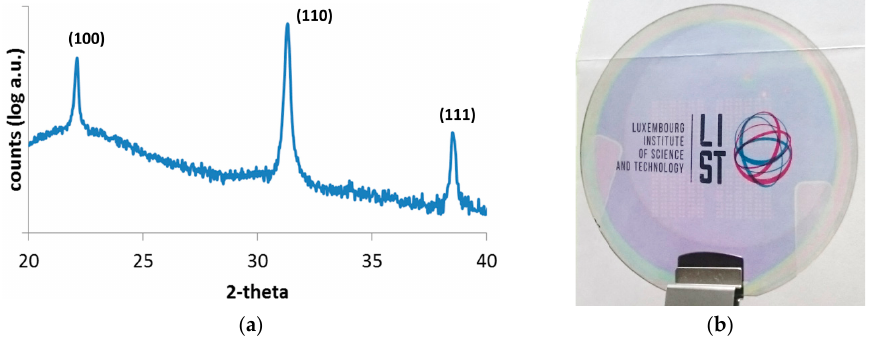
Figure 1. ( a ) The θ -2 θ pattern of 200-nm-thick Pb(Zr 0.52 Ti 0.48 )O 3 (PZT) film deposited by spin coating on TiO 2 /fused silica and crystallized at 700 °C. All peaks correspond to the perovskite structure; ( b ) Optical image of a 2’’-diameter wafer coated with 20 nm of TiO 2 , 200 nm of PZT, and 115 nm of patterned Al-doped zinc oxide (AZO), the latter being visible in the central area of the wafer. TiO 2 exhibits a purplish color. Note that the logo is visible through the glass wafer.